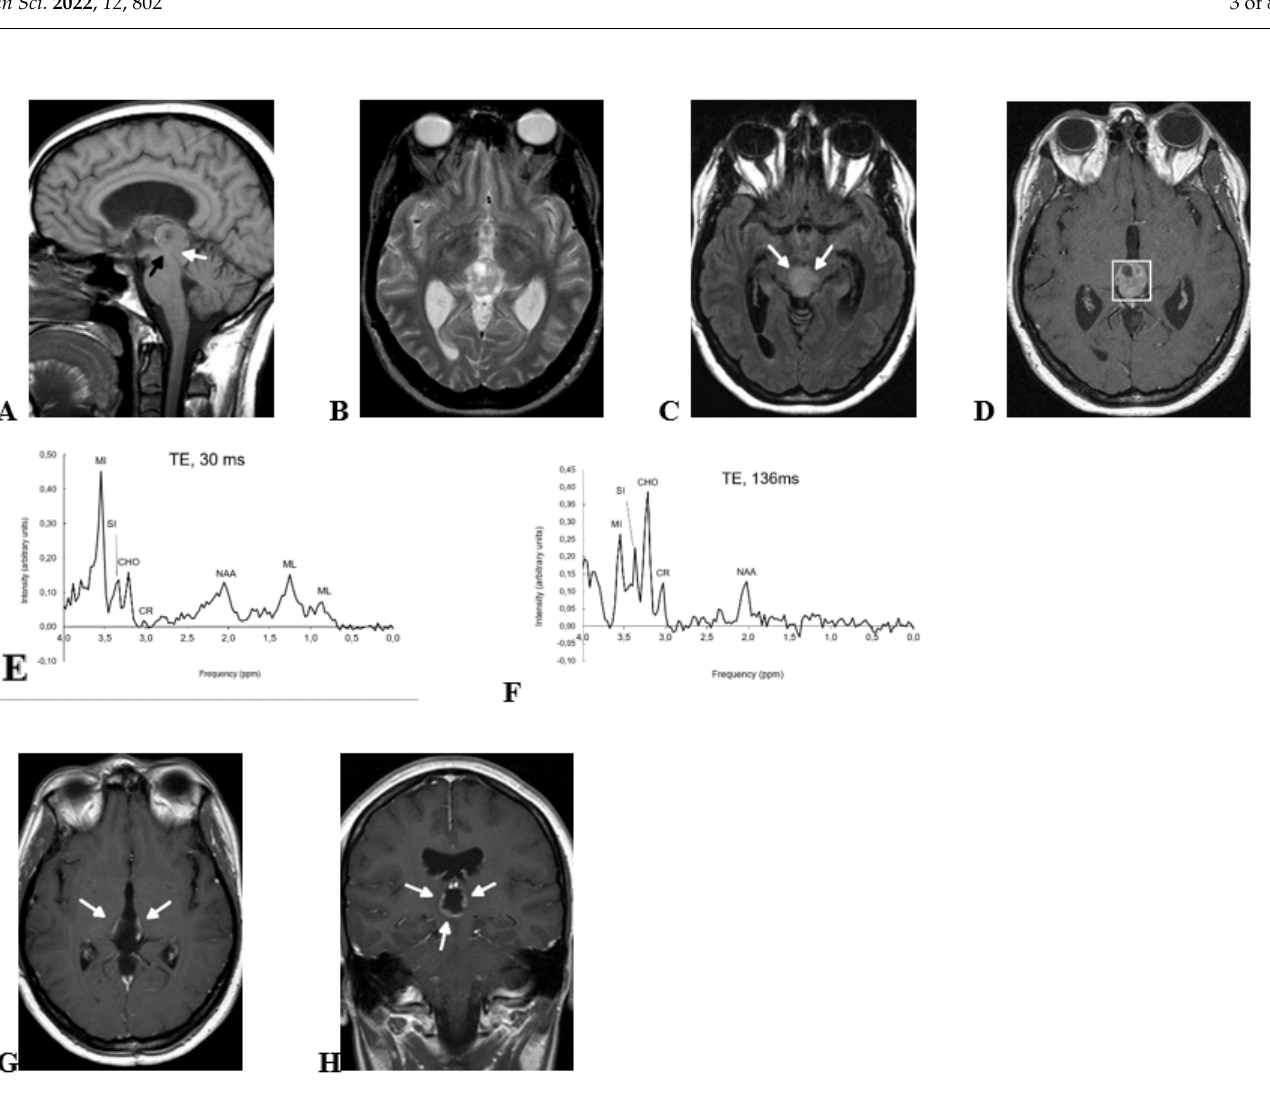
Figure 1. Preoperative MRI ( A – D ), preoperative 1H-MRS ( E , F ), and postoperative MRI ( G , H ) of a 30-yr-old woman with pathology-confirmed PTPR. ( A ) Sagital T1-wi show an inhomogeneous pineal region mass with small areas of cystic degeneration. Sylvian aqueduct compression secondary to the mass (black arrow) and midbrain tegmentum infiltration (white arrow, see also Figure 1C) are shown in the image. ( B ) Axial T2-wi show that the mass signal is heterogeneous with multiple small cystic areas. Tumor margins are well defined at this level, and slight mass-effect is produced to both thalami. ( C ) Axial FLAIR-wi at a lower level than B shows midbrain infiltration (white arrows). ( D ) Contrast-enhanced T1-wi confirms a well-defined mass at this level with small cystic areas and non-homogeneous enhancement. Voxel for spectroscopy is shown. ( E ) Short TE 1H-MRS (TE, 30 ms) shows very high myoinositol signal at 3.55 ppm. ( F ) Long TE 1H-MRS (TE, 136 ms) shows that the intensity at 3.55 ppm is reduced at this echo time due to short T2 relaxation time of myoinositol. MI, myoinositol; SI, scyllo-inositol; CHO, choline; CR, creatine; NAA, N-acetyl-aspartate; ML, mobile lipids. ( G , H ), postoperative axial and coronal contrast-enhanced T1-wi show annular contrast enhancement, suggesting partial surgical resection (arrows). Adjuvant treatment with radiotherapy was administered, and contrast enhancement disappeared in follow-up (not shown).